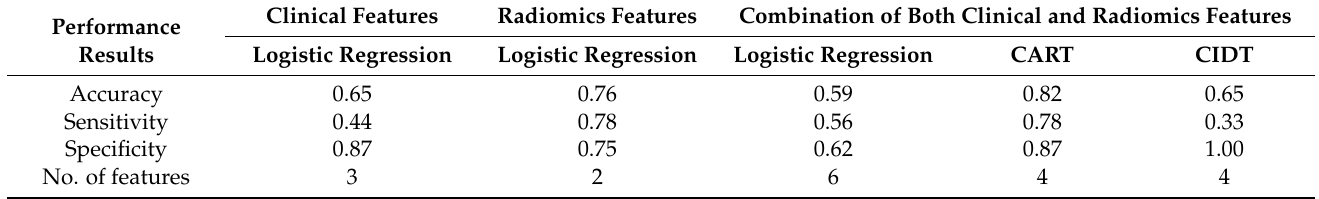
Table 3. Multivariate analysis. Results of machine learning approaches (logistic regression and tree-based algorithms) in the prediction of tumor grading.